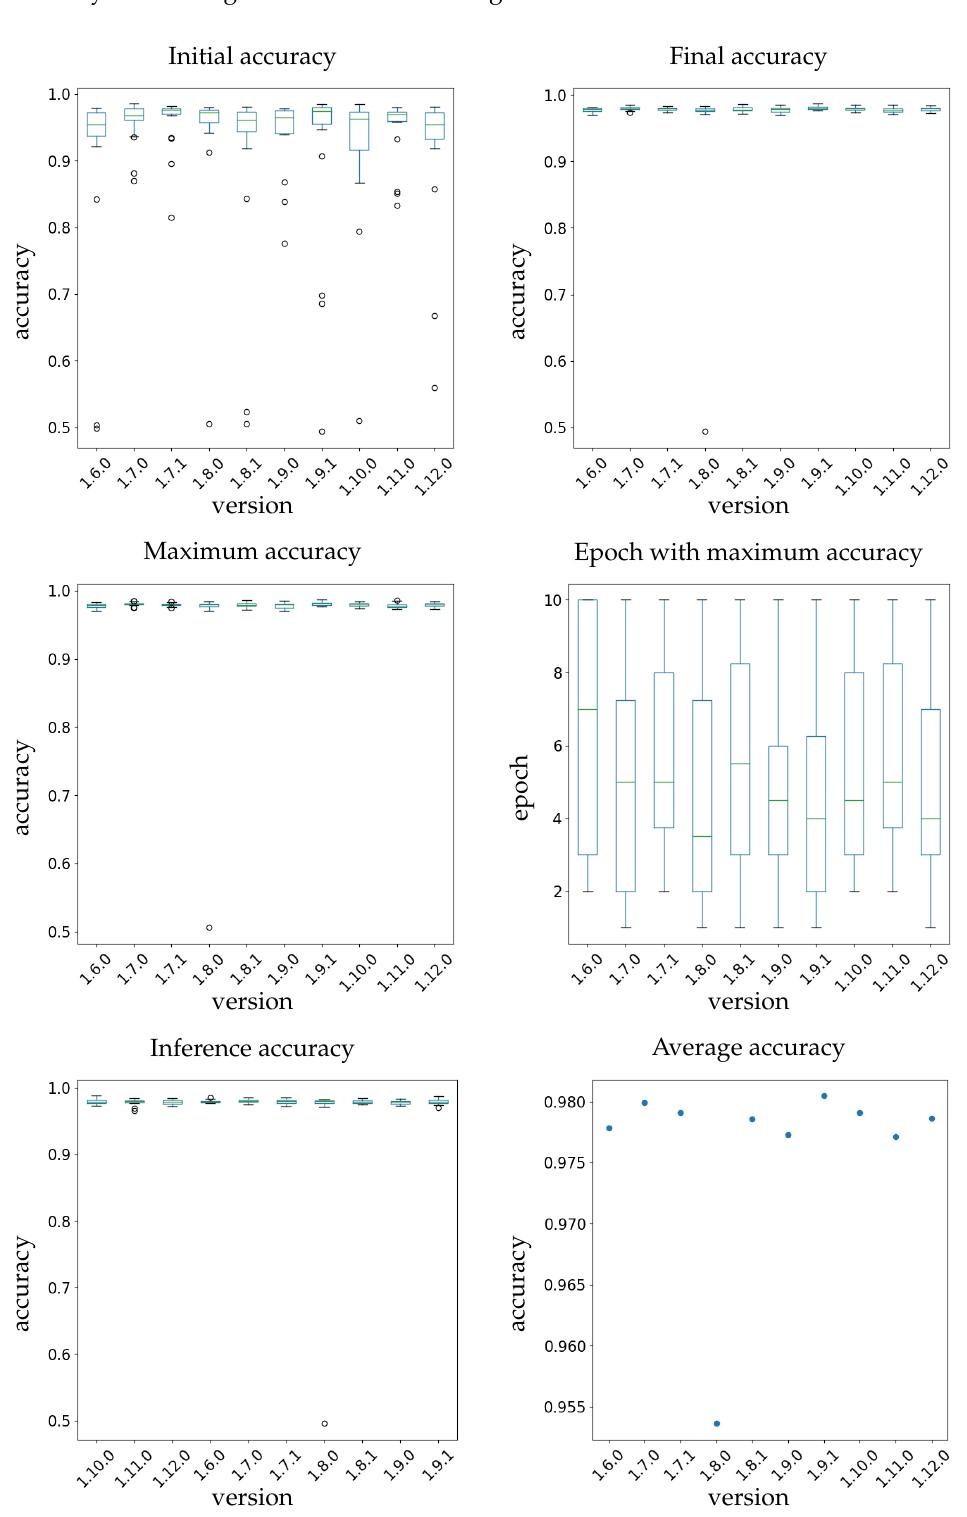
Figure 10. The results for the 2D Gaussian dataset using